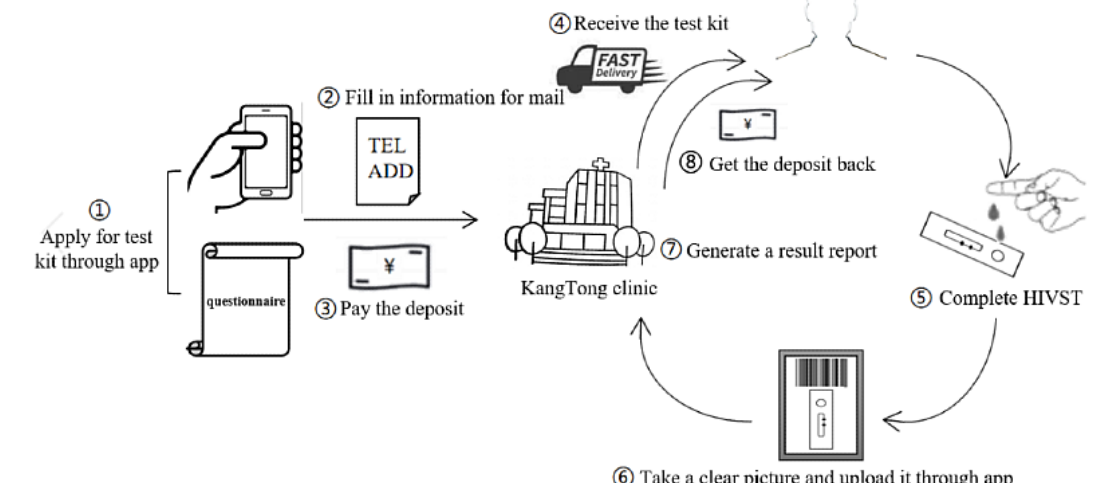
Figure 2. Flow chart of the “Mailing rapid test reagent kit” HIV self-testing (HIVST)